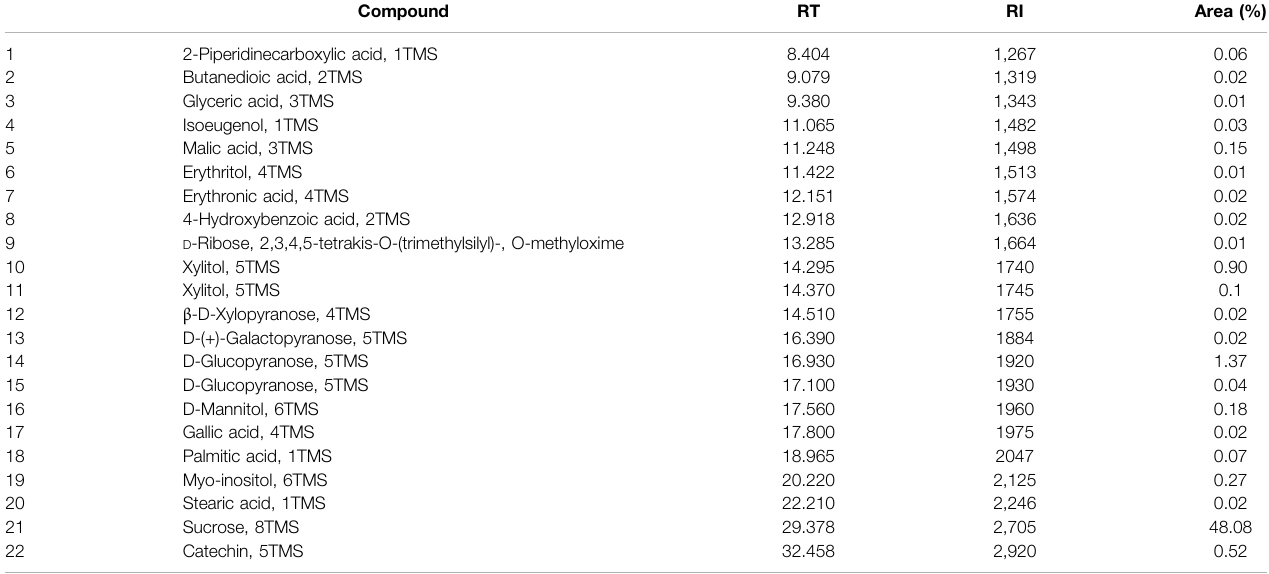
TABLE 1 | Phytochemical compounds identi fi ed in the hydroalcoholic bark extract of A. colubrina by GC-MS (Maia et al., 2021).